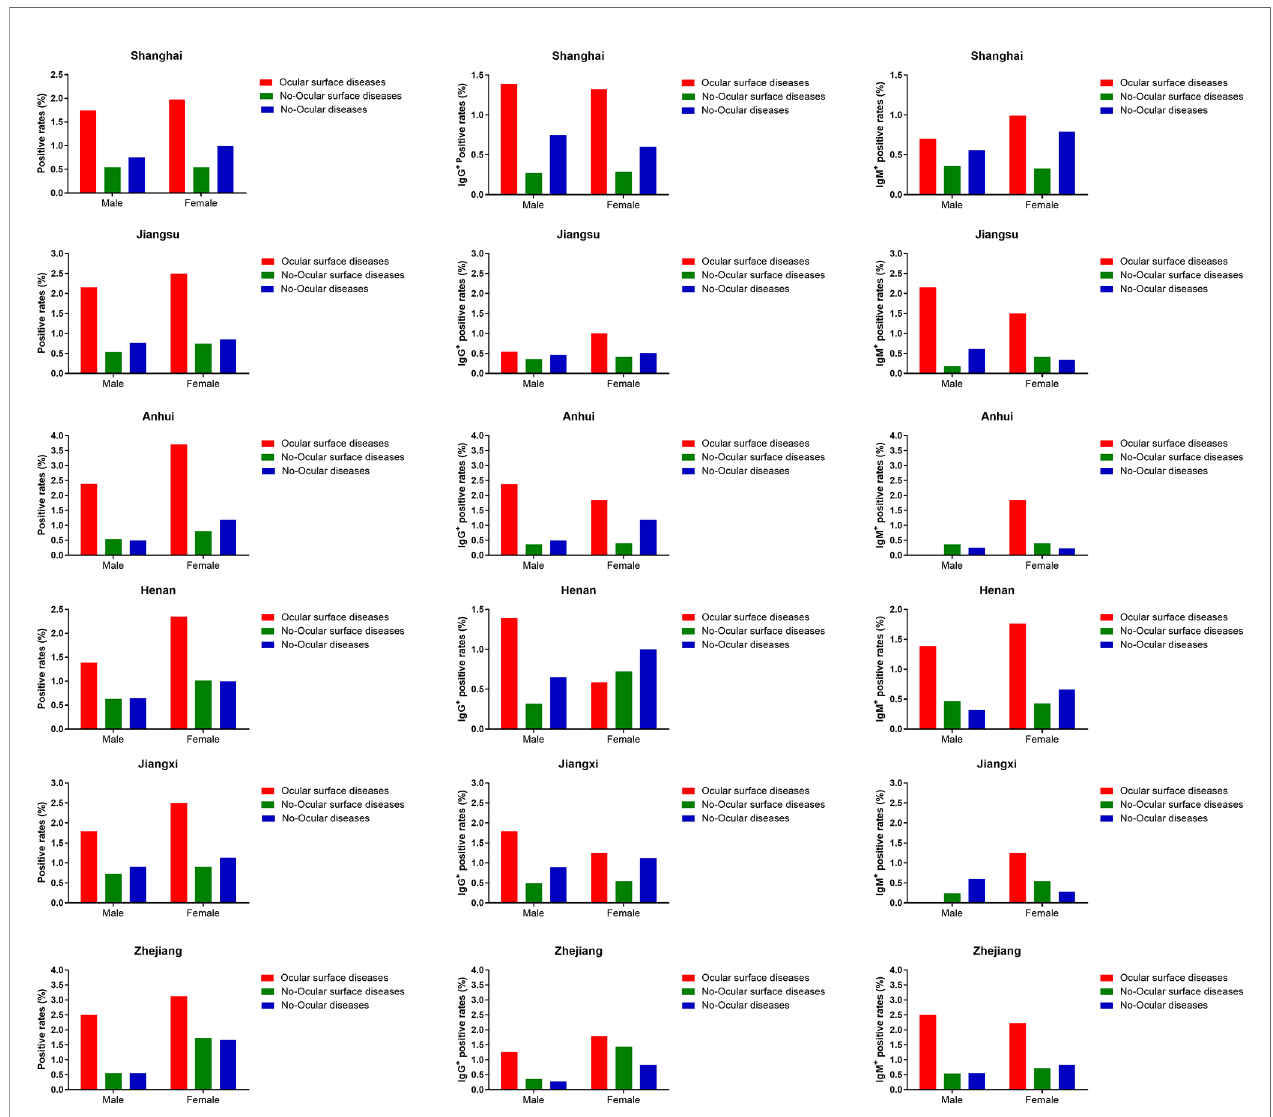
FIGURE 4 | The seroprevalence of antibodies to SARS-CoV-2 in districts subgroup. In each district, the seroprevalence of antibodies to SARS-CoV-2 was particularly higher in ocular surface diseases compared with no-ocular surface diseases and no-ocular diseases in male and female